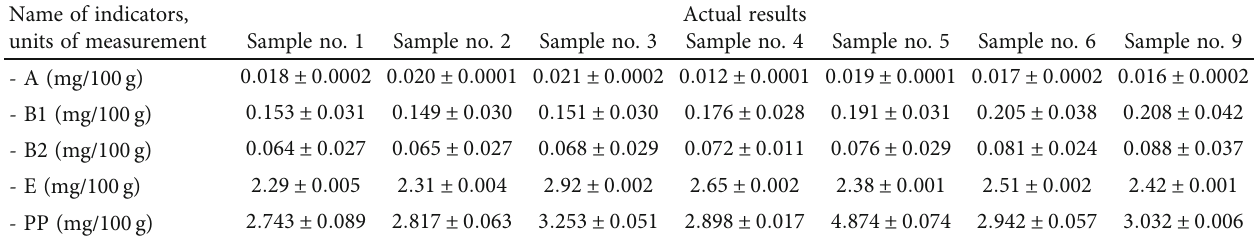
Table 9: Vitamin composition of various bun formulations.